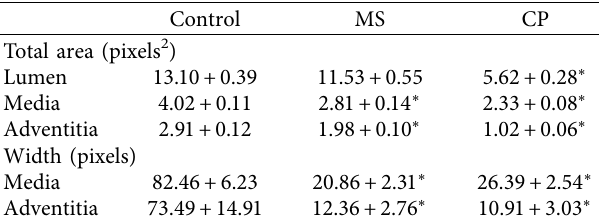
Table 2: Area of the lumen, the media (Med), and the adventitia (Adv) and width of the layers of aortas from control, MS, and CP rats.